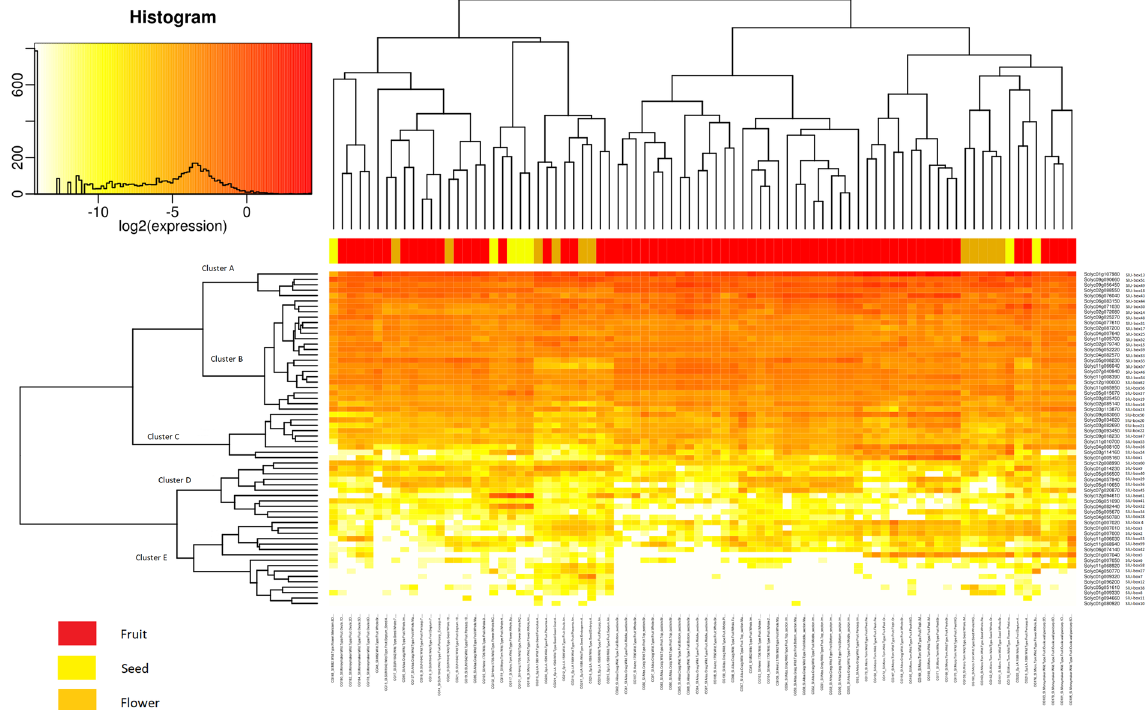
Figure 5. The gene expression level of the 62 U-box gene family members in reproductive tissues (flower, fruit, and seed) was represented by a heat map. (For detailed conditions refer Supplementary Table